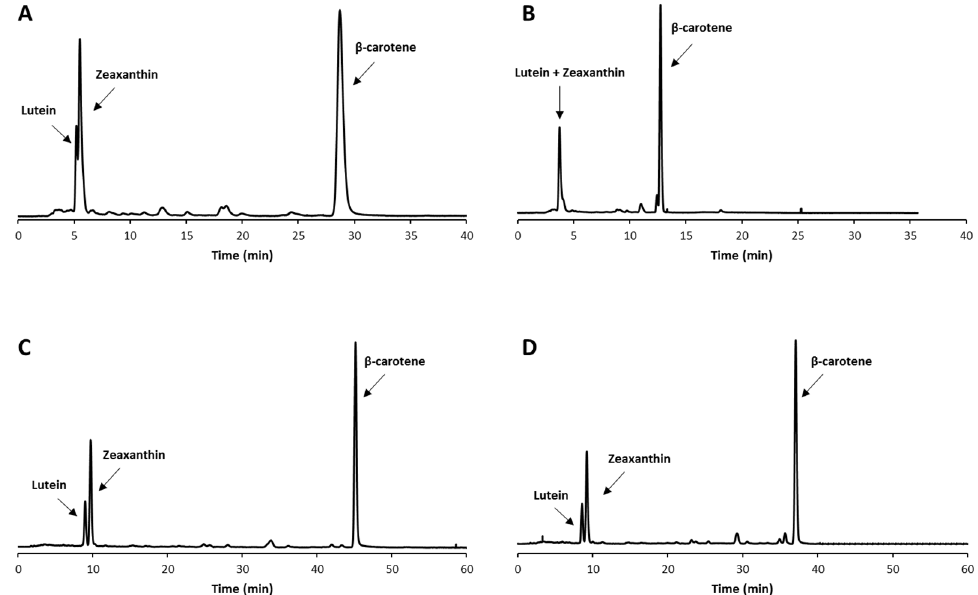
Figure 1. Chromatographic profiles of lutein, zeaxanthin and β -carotene standards with different gradient elution programs: ( A ) 0 min: 100% methanol, 0–30 min: 65% methanol and 35% MTBE, 30- 60 min: 30% methanol and 70% MTBE, 0’: 100%A, 11, flow rate 1.2 mL/min; ( B ) 0 min: 80% metha- nol/water (97/3) and 20% MTBE, 0-2 min: 60% methanol/water (97/3) and 40% MTBE, 2-14 min: 60% methanol/water (97/3) and 40% MTBE, 14-27 min: 100% MTBE, flow rate 1.0 mL/min; ( C ) 0 min: